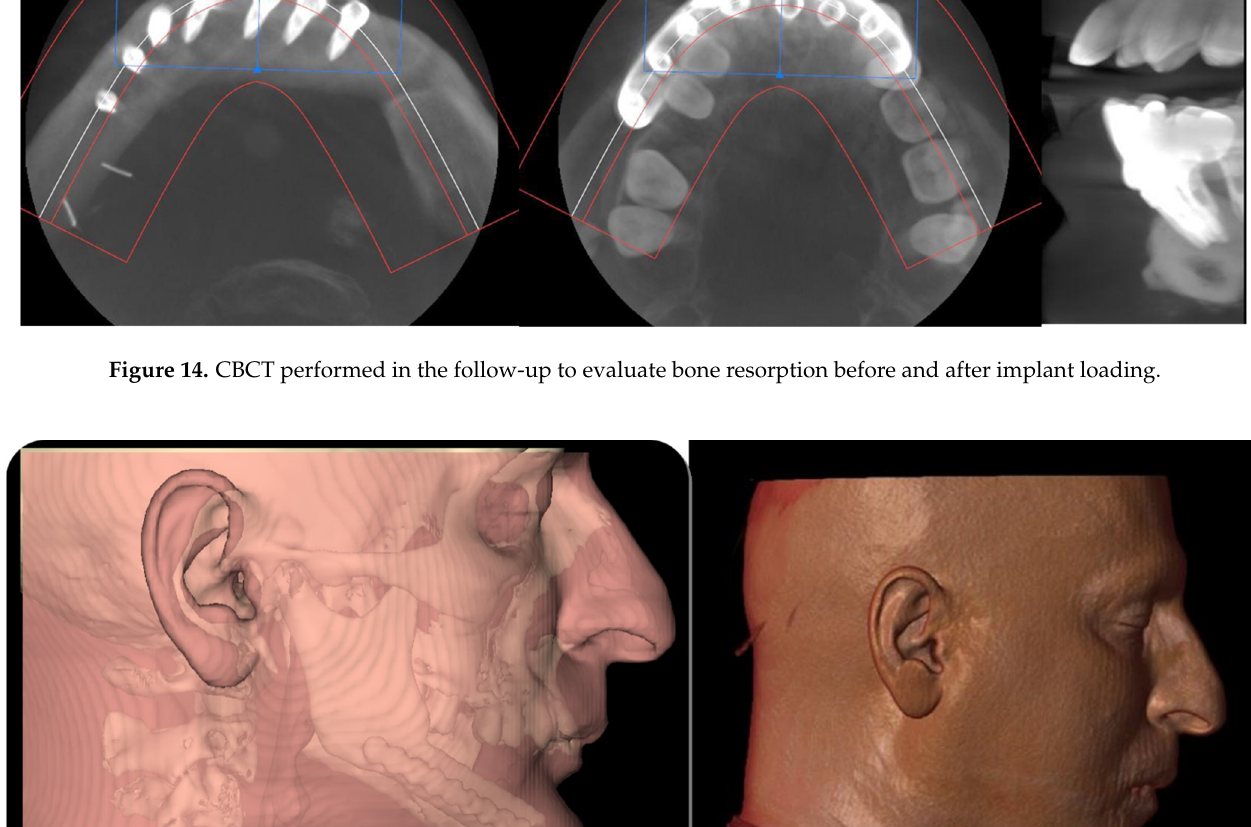
Figure 13. CT Scan and CBCT were performed in the postoperative follow-up, providing relevant quantitative data re- garding bone volume and bone resorption.